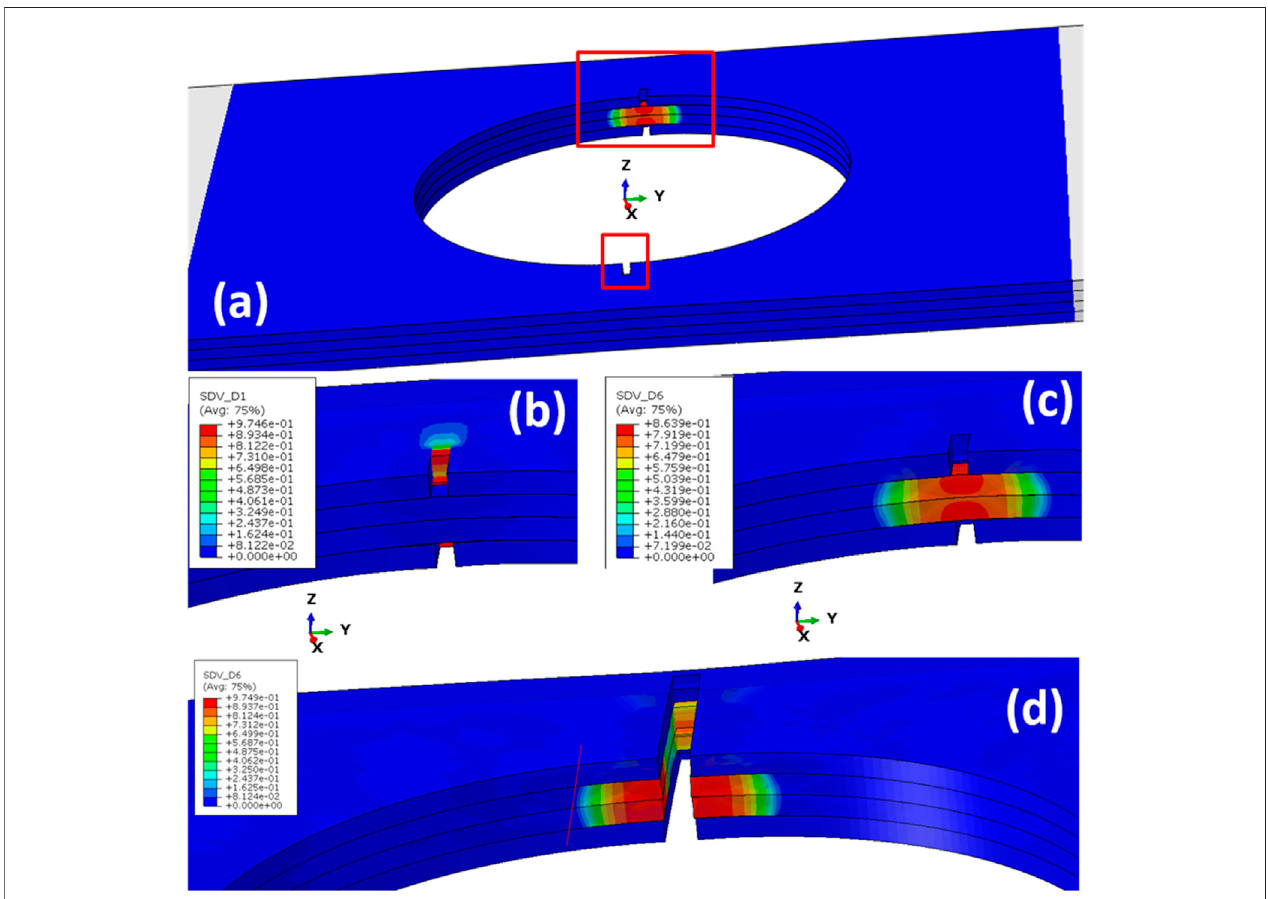
FIGURE 10 | Damage development: (A) damage onset; (B) cracks propagate in 0 o plies (external tensile stress σ (cid:1) 122 MPa), (C) shear damage already accumulated in ± 45 o plies (external tensile stress σ (cid:1) 122 MPa); (D) cracks propagate to ± 45 o plies while the external tensile stress snaps back to 118 MPa. SDV_D1 and SDV_D6 stand for damage variables d N , where N equals ± 1 and 6,